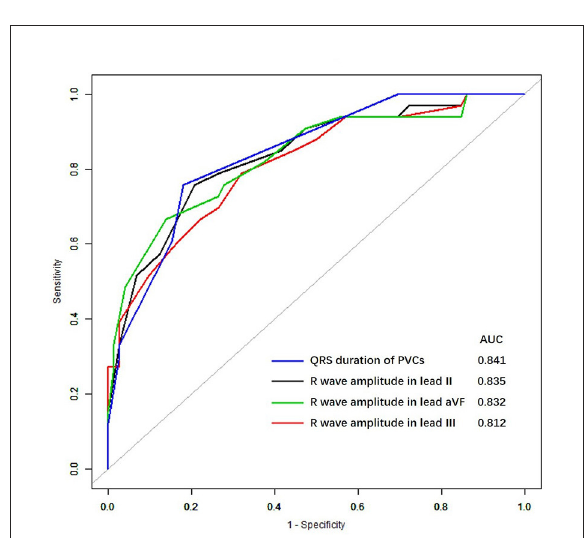
FIGURE2 Receiver-operating characteristic curves for premature ventricular complexes in the inferior right ventricular outflow tract. AUC, the area under the receiver-operating characteristic